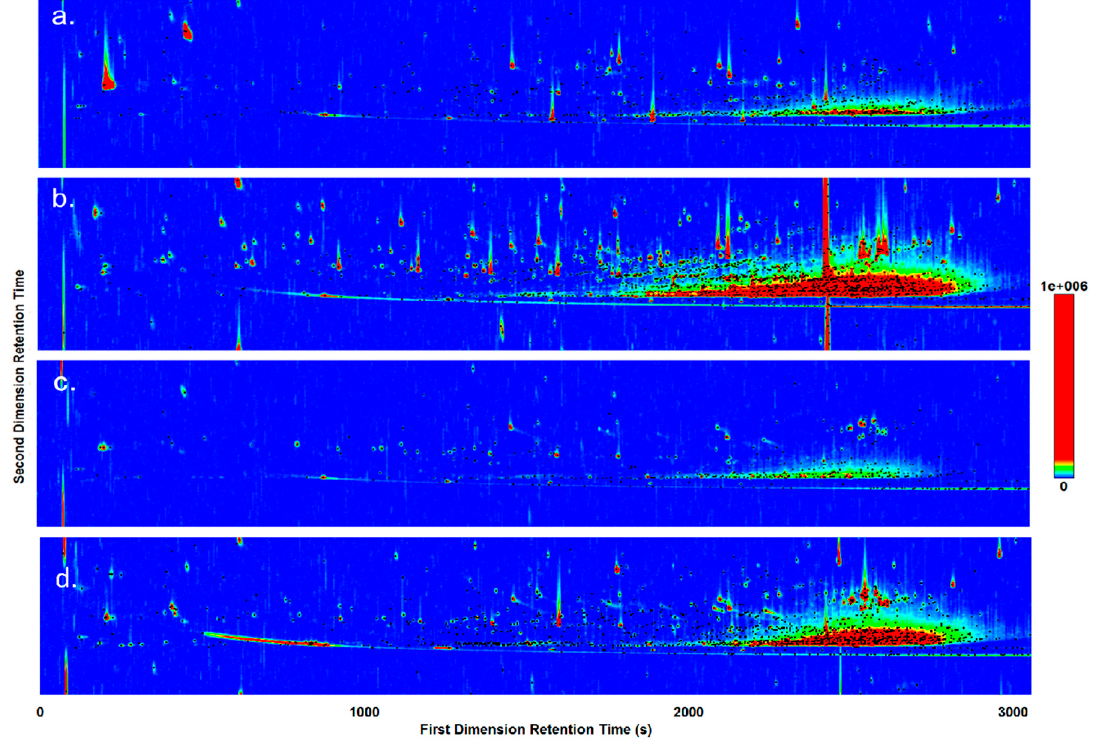
Figure 1. Total ion chromatograms showing the data obtained from a representative sample from ( a ) known African ivory, ( b ) vouchered koala bone, ( c ) IWT 348B, ( d ) IWT 276A.